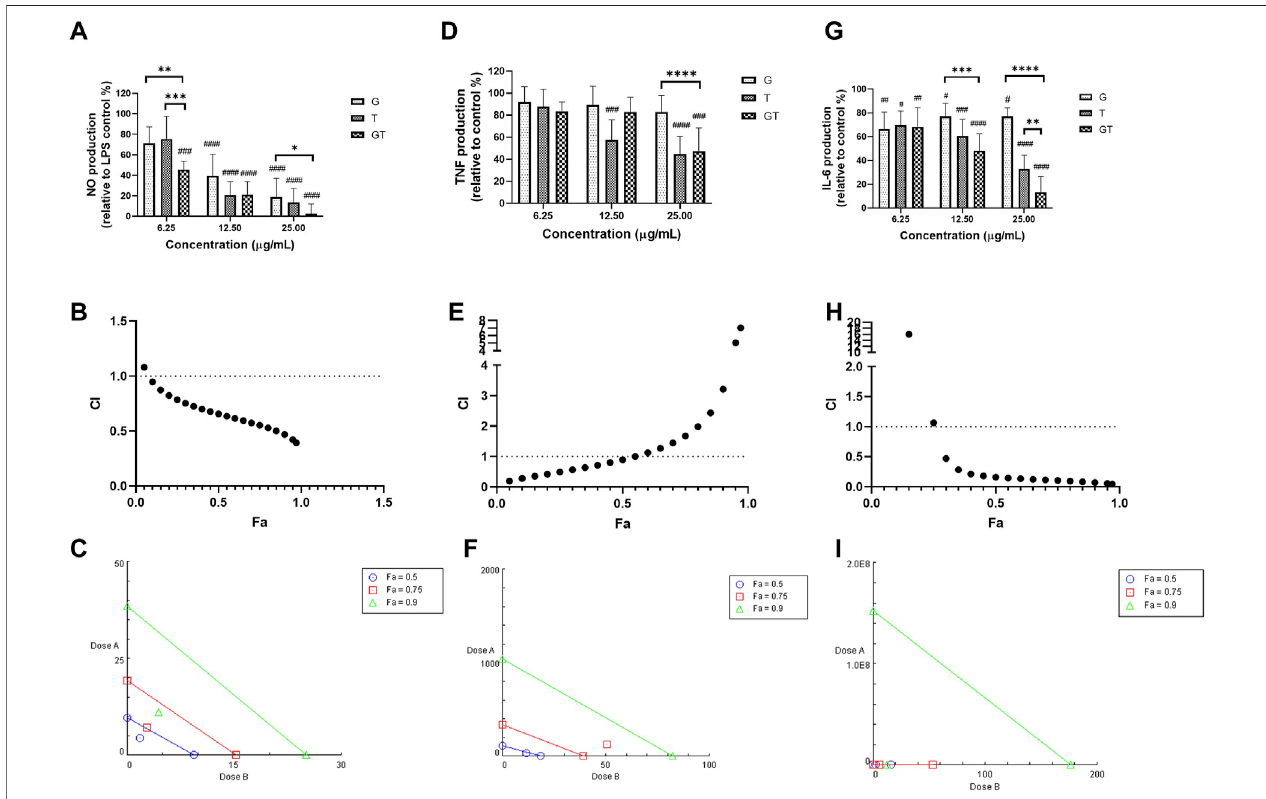
FIGURE 1 | G, T and GT (all at 6.25, 12.5 and 25 μ g/ml) dose-dependently inhibited NO (A) , TNF (D) and IL-6 (G) in LPS-induced RAW 264.7 cells (n ≥ 3). The production of NO, TNF and IL-6 were expressed as percentage relative to LPS stimulation control (set as 100%). # p < 0.05, ## p < 0.01, ### p < 0.001, #### p < 0.0001 vs. LPS stimulation control. ** p < 0.01, *** p < 0.001, **** p < 0.0001 compared between GT to G or T at the same concentration level. The synergistic effects of GT were determinedbytheCI-FacurvesinreducingNO (B) ,TNF (E) andIL-6 (H) .CIvaluesrepresenttheinteractioninGT,withCI < 1,CI=1andCI > 1referringtosynergy, addition and antagonism, respectively. Fa on the X-axis is de fi ned as the fraction effect level, and herein it refers to NO, TNF and IL-6 inhibitory effect, respectively. Isobologram analysis of GT in NO (C) , TNF (F) and IL-6 (I) when the default set of Fa values at 0.5, 0.75 and